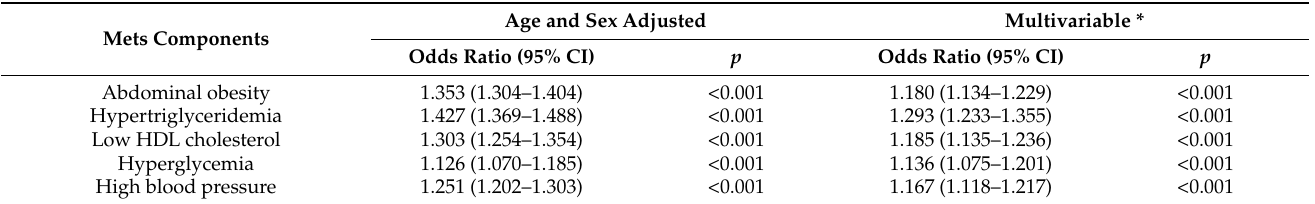
Table 4. Associations between MetS components and new-onset hyperuricemia, determined using multivariable logistic regression